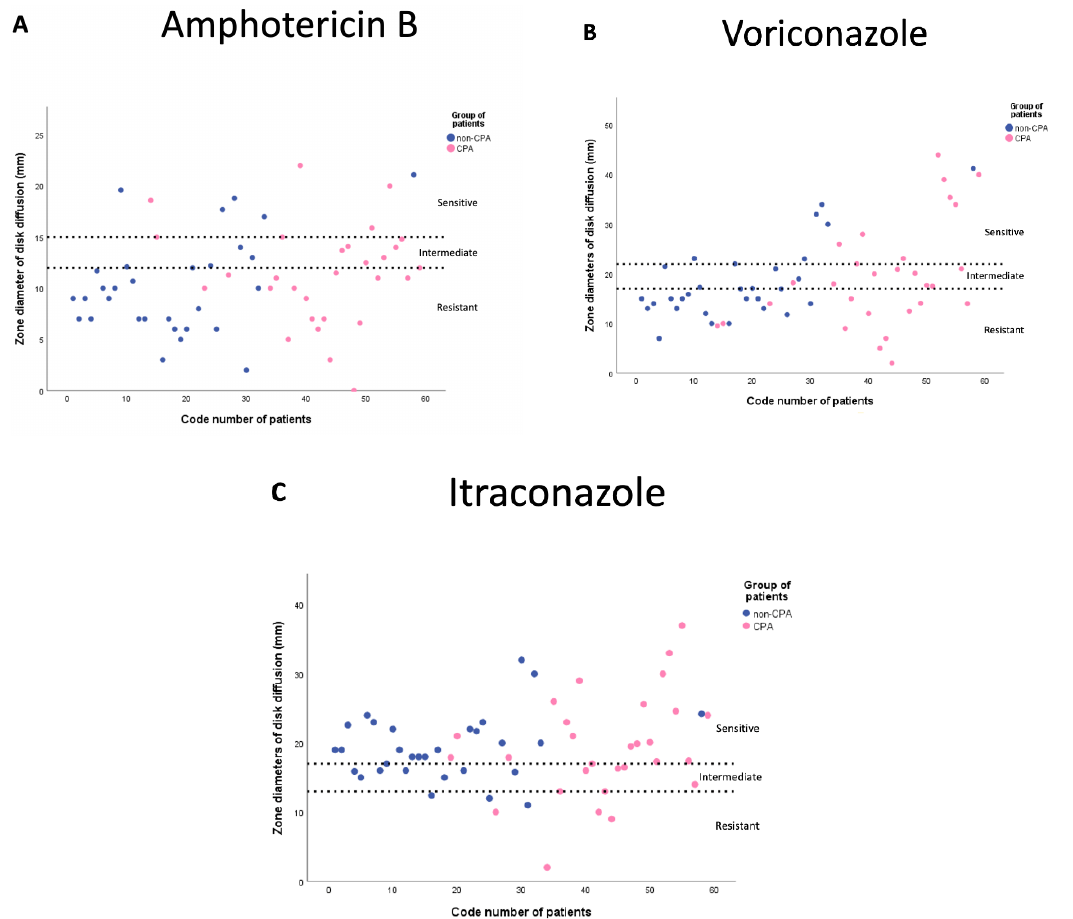
Figure 1. Scatter plot diagrams of zone inhibition diameters of disk diffusion against amphotericin B ( A ), voriconazole ( B ) and itraconazole ( C ) in the CPA and non-CPA groups. Zone diameter categories (dash lines): amphotericin B (susceptible ≥ 15 mm; intermediate 13 to 14 mm; resistant ≤ 12 mm), itraconazole and voriconazole (susceptible ≥ 17 mm; intermediate 14 to 16 mm; resistant ≤ 13 mm) (15).